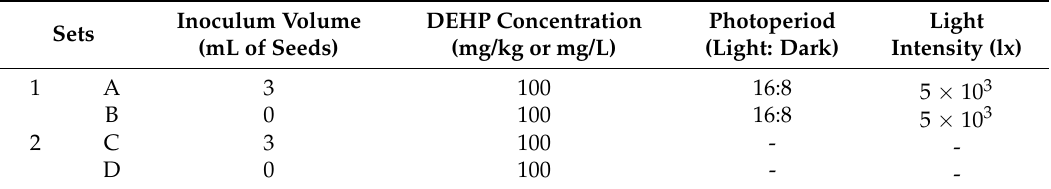
Table 2. Experimental sets for DEHP biodegradation with environmental